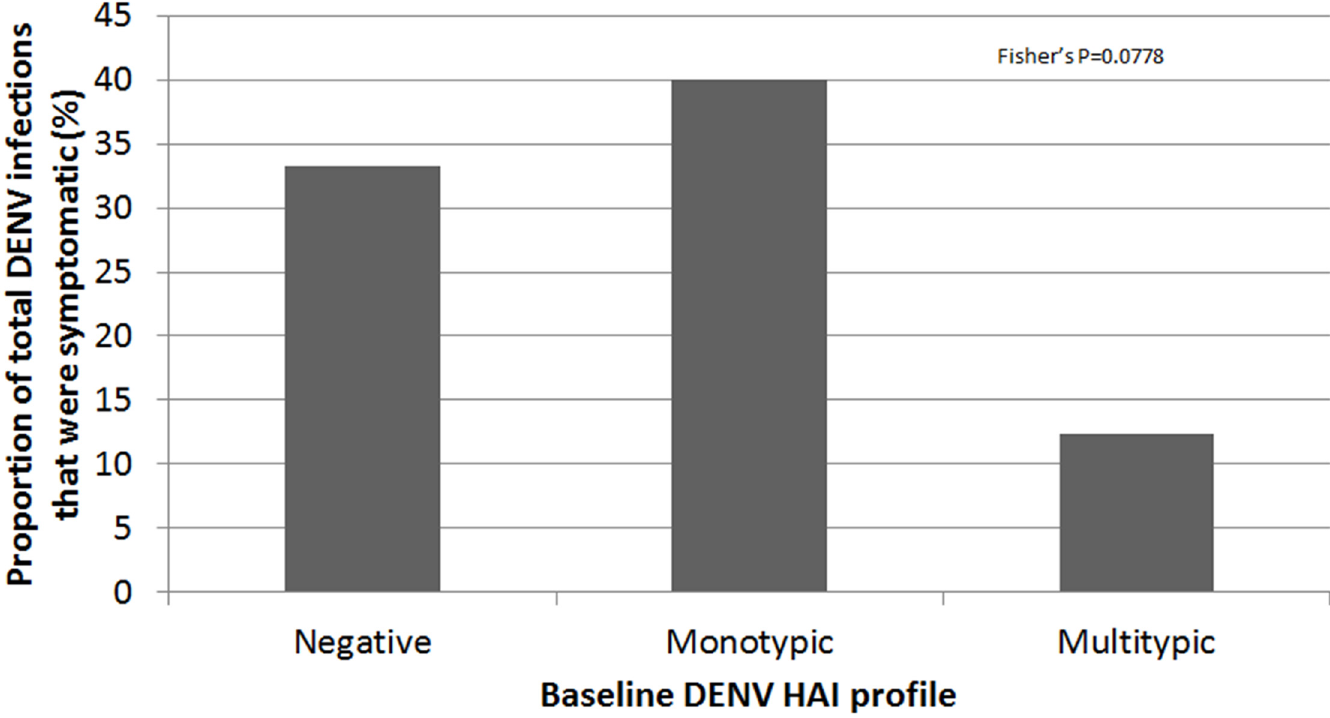
Fig 4. Proportion of symptomatic dengue virus (DENV) infections among total (symptomatic and subclinical) DENV infections in per-protocol subjects with different DENV hemagglutination inhibition (HAI) profiles at enrolment. Negative HAI: 4/12; monotypic HAI: 2/5; multitypic HAI: 7/57 (chi- square, p = 0.068). Three symptomatic cases were not included because of missing HAI titers.